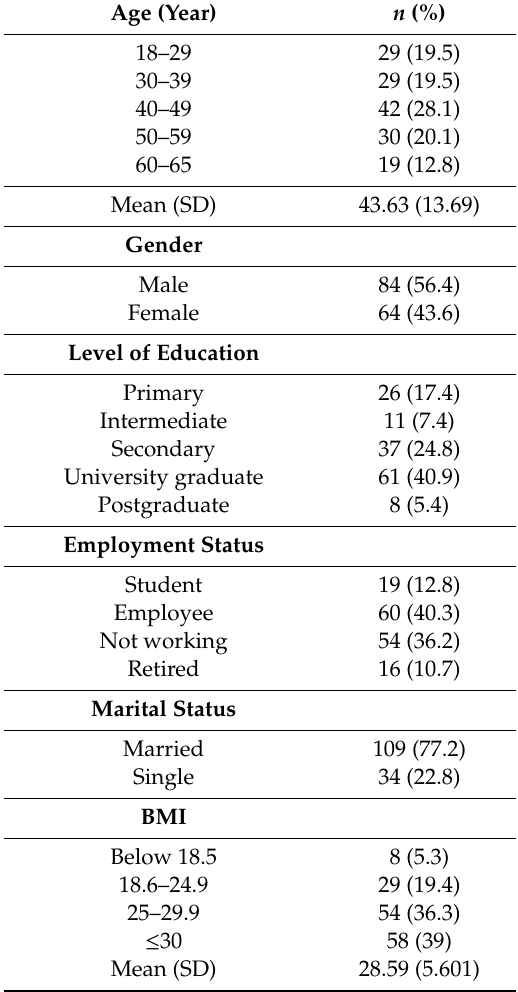
Table 1. Demographic data of the study participants ( n = 149).